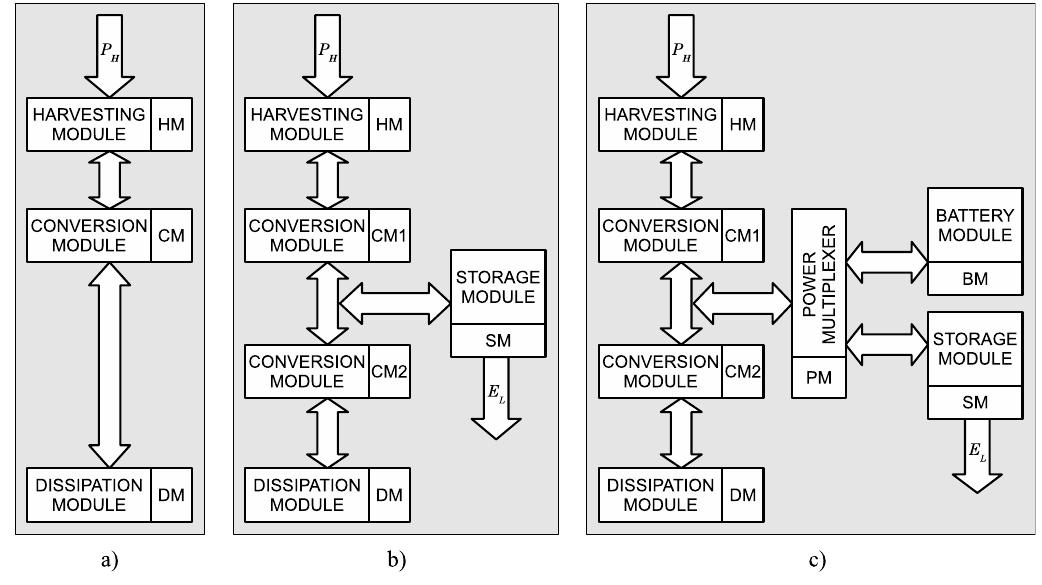
Figure 4. Topologies of harvesting systems: ( a ) autonomous harvesting system; ( b ) autonomous hybrid harvesting system; ( c ) battery-supplemented harvesting